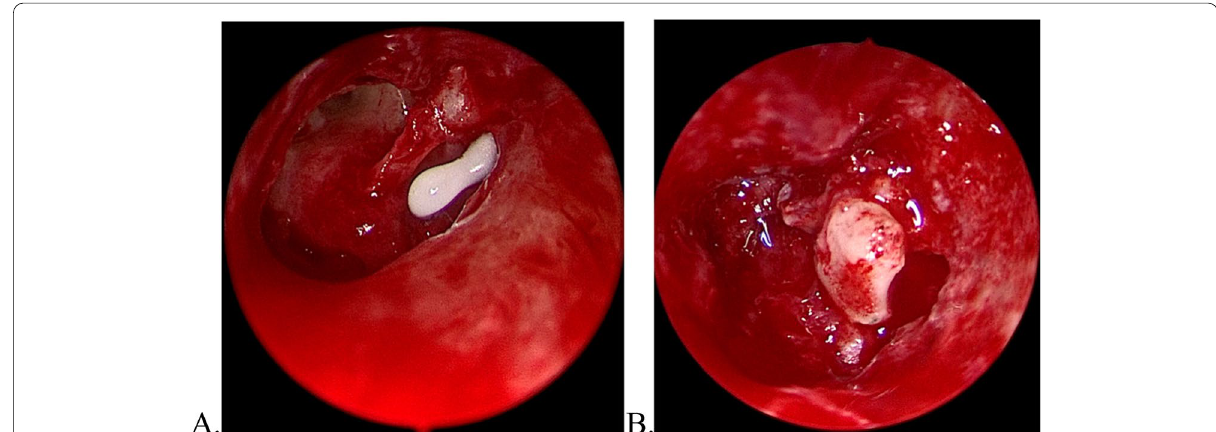
Fig. 6 A Endoscopic reconstruction of the long process of incus with bone cement. B Endoscopic incus interposition graft ossiculoplasty